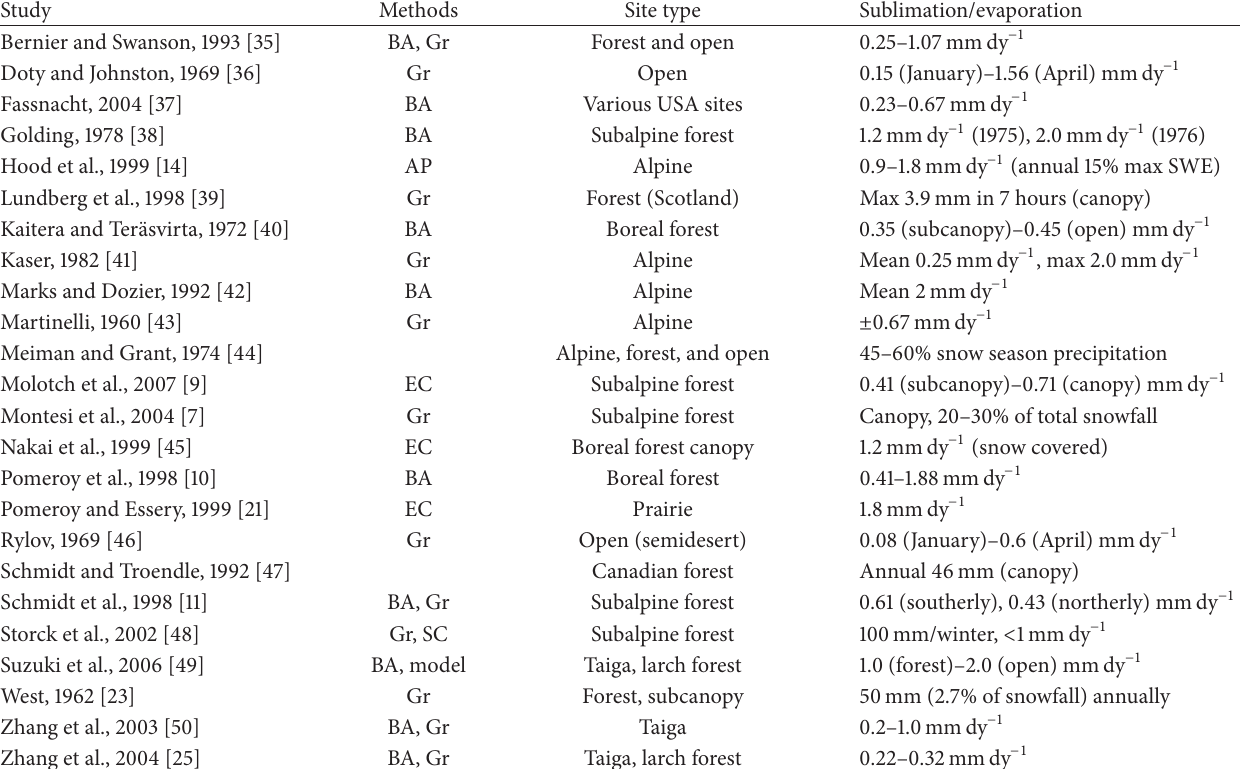
Table 1: Slightly modified from Jackson and Prowse [26], selected studies of sublimation from snow covered